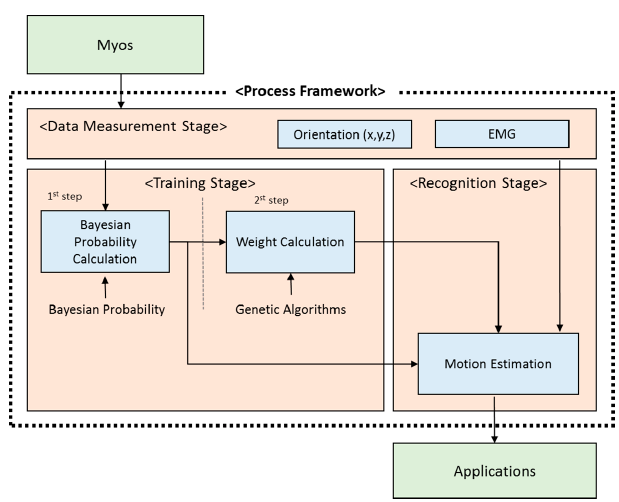
Figure 3. Components and structures of the proposed method.